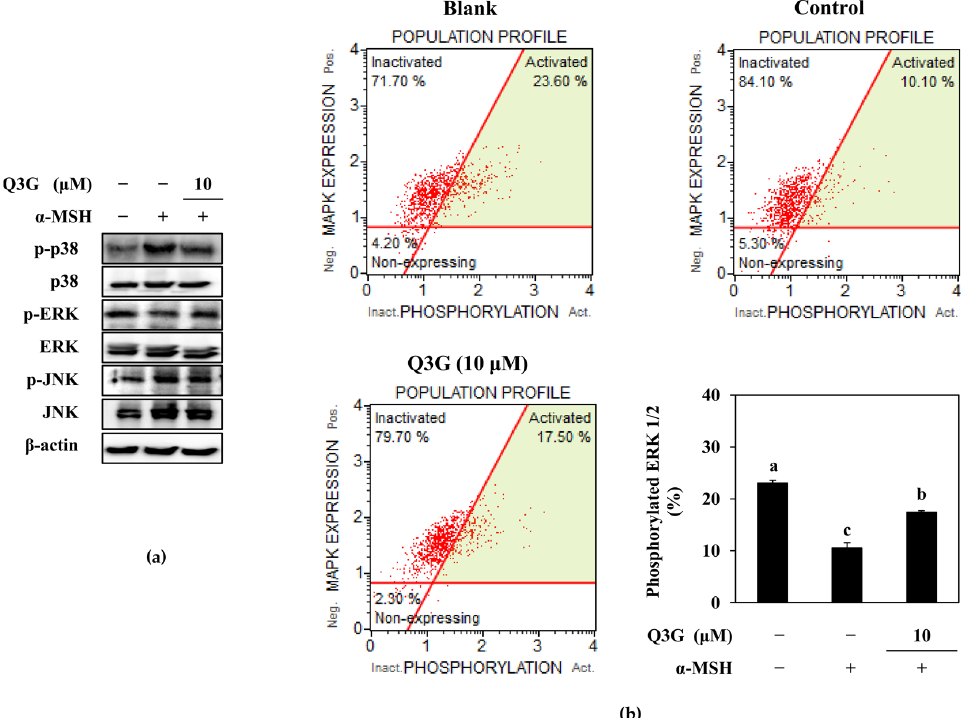
Figure 5. Effect of Q3G on the MAPK activation in α -MSH-stimulated B16F10 melanoma cells. ( a ) Effect of Q3G on the phosphorylated (p-) and total protein levels of p38, JNK, and ERK MAPKs was analyzed by western blot after 24 h treatment. ( b ) Activation level of ERK1/2 was measured with flow cytometry and given as percentage of activated ERK1/2 in total expressed ERK1/2. Blank: Non-stimulated untreated group, Control: α -MSH-stimulated untreated group. a–c groups with different superscript letters are significantly different, whereas same superscript letters mean no significant difference according to Duncan’s multiple range post-hoc test ( p < 0.05).